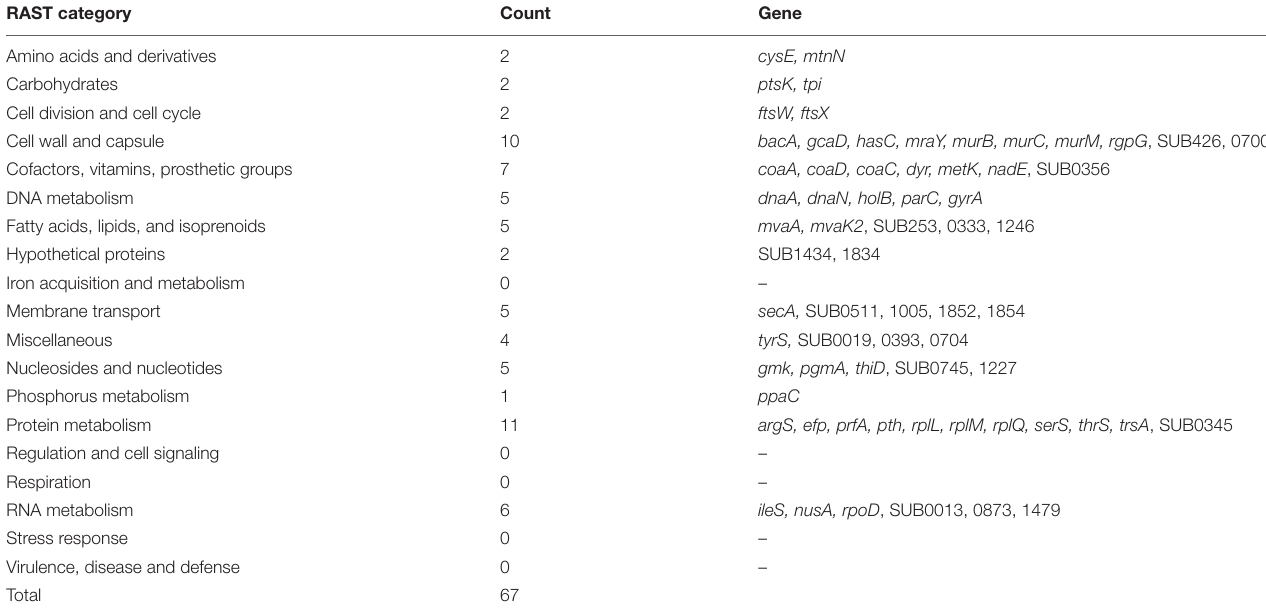
TABLE 4 | Rapid Annotation using Subsystem Technology classification of S. uberis CDS containing insertions only within the last 10% of the